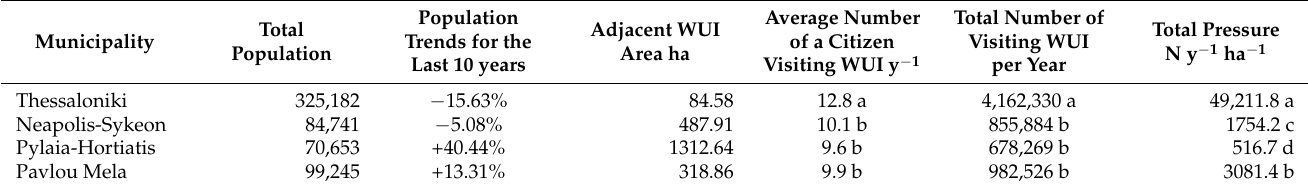
Table 6. Human population pressure (in terms of number of human visits per year per hectare) in the WUI area of Thessaloniki. Note that we consider visiting turnovers similar between the municipalities. Values in the same column followed by different letters indicate significant differences between